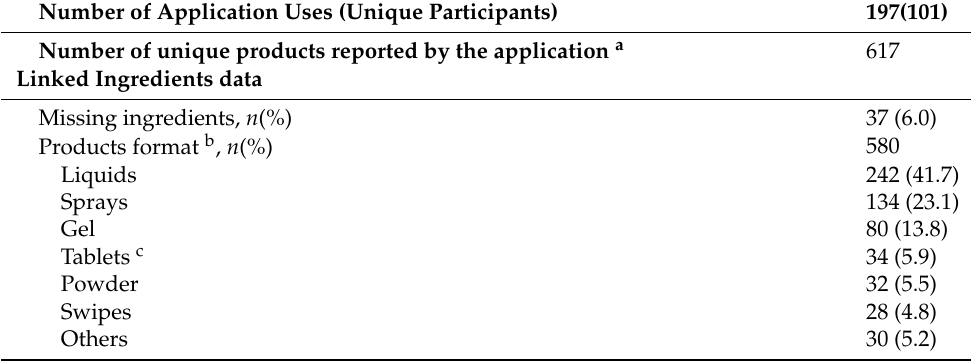
Table 2. HDCP characteristics among 101 women participating in the SEPAGES study for all smart- phone